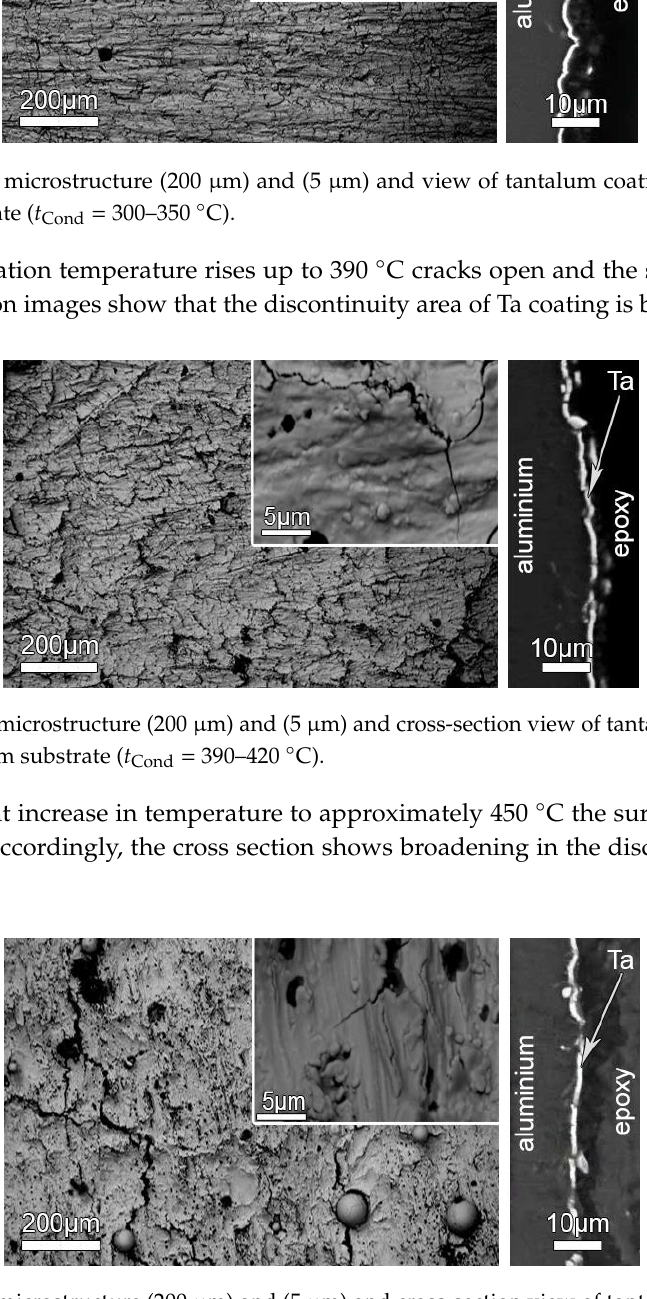
Figure 4. Surface microstructure (200 µ m) and (5 µ m) and cross-section view of tantalum coating on a Figure 4. Surface microstructure (200 μm) and (5 μm) and cross-section view of tantalum coating on Figure 4. Surface microstructure (200 μm) and (5 μm) and cross-section view of tantalum coating on Figure 4. Surface microstructure (200 μm) and (5 μm) and cross-section view of tantalum coating on gradient aluminum substrate ( t Cond ~ 450 ◦ a gradient aluminum substrate ( t Cond ~ 450 °С). a gradient aluminum substrate ( t Cond ~ 450 °С). a gradient aluminum substrate ( t Cond ~ 450 °С).